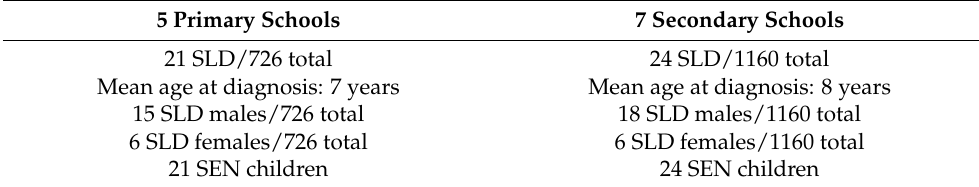
Table 1. Total number of children of the schools, number of children diagnosed with SLD, gender, the average age of onset of